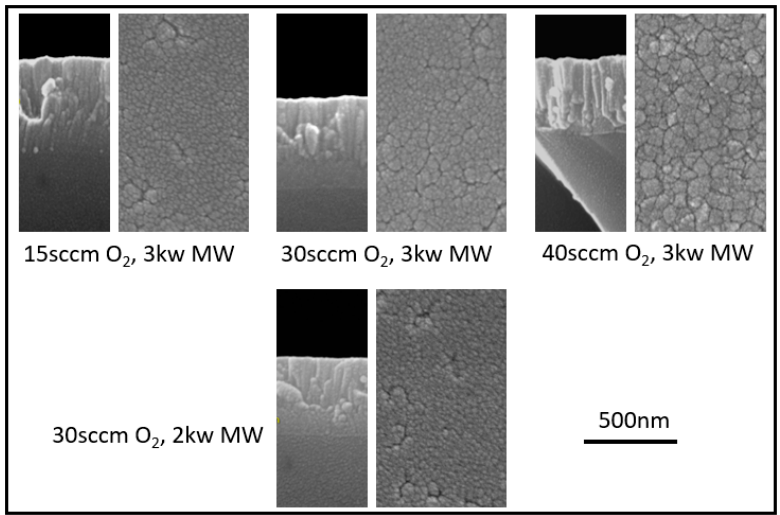
Figure 5. Scanning electron microscopy (SEM) images of TiO 2 thin films: cross-section and top surface.